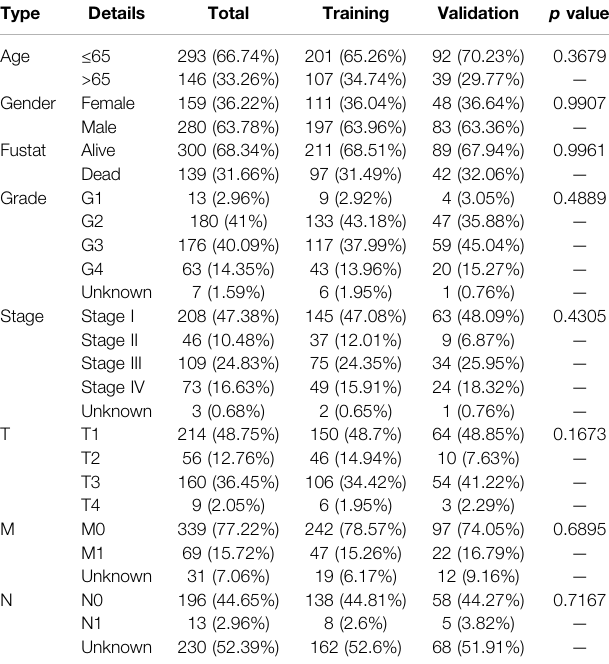
TABLE 1 | Clinicopathological features of 439 ccRCC